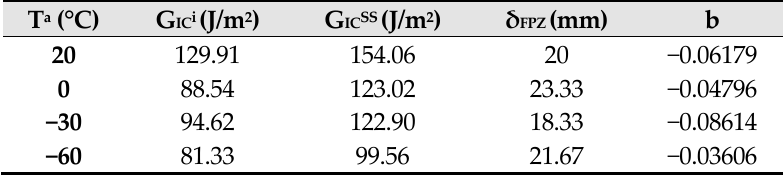
Table1. Gompertz parameters obtained from AS4/3501-6 material.